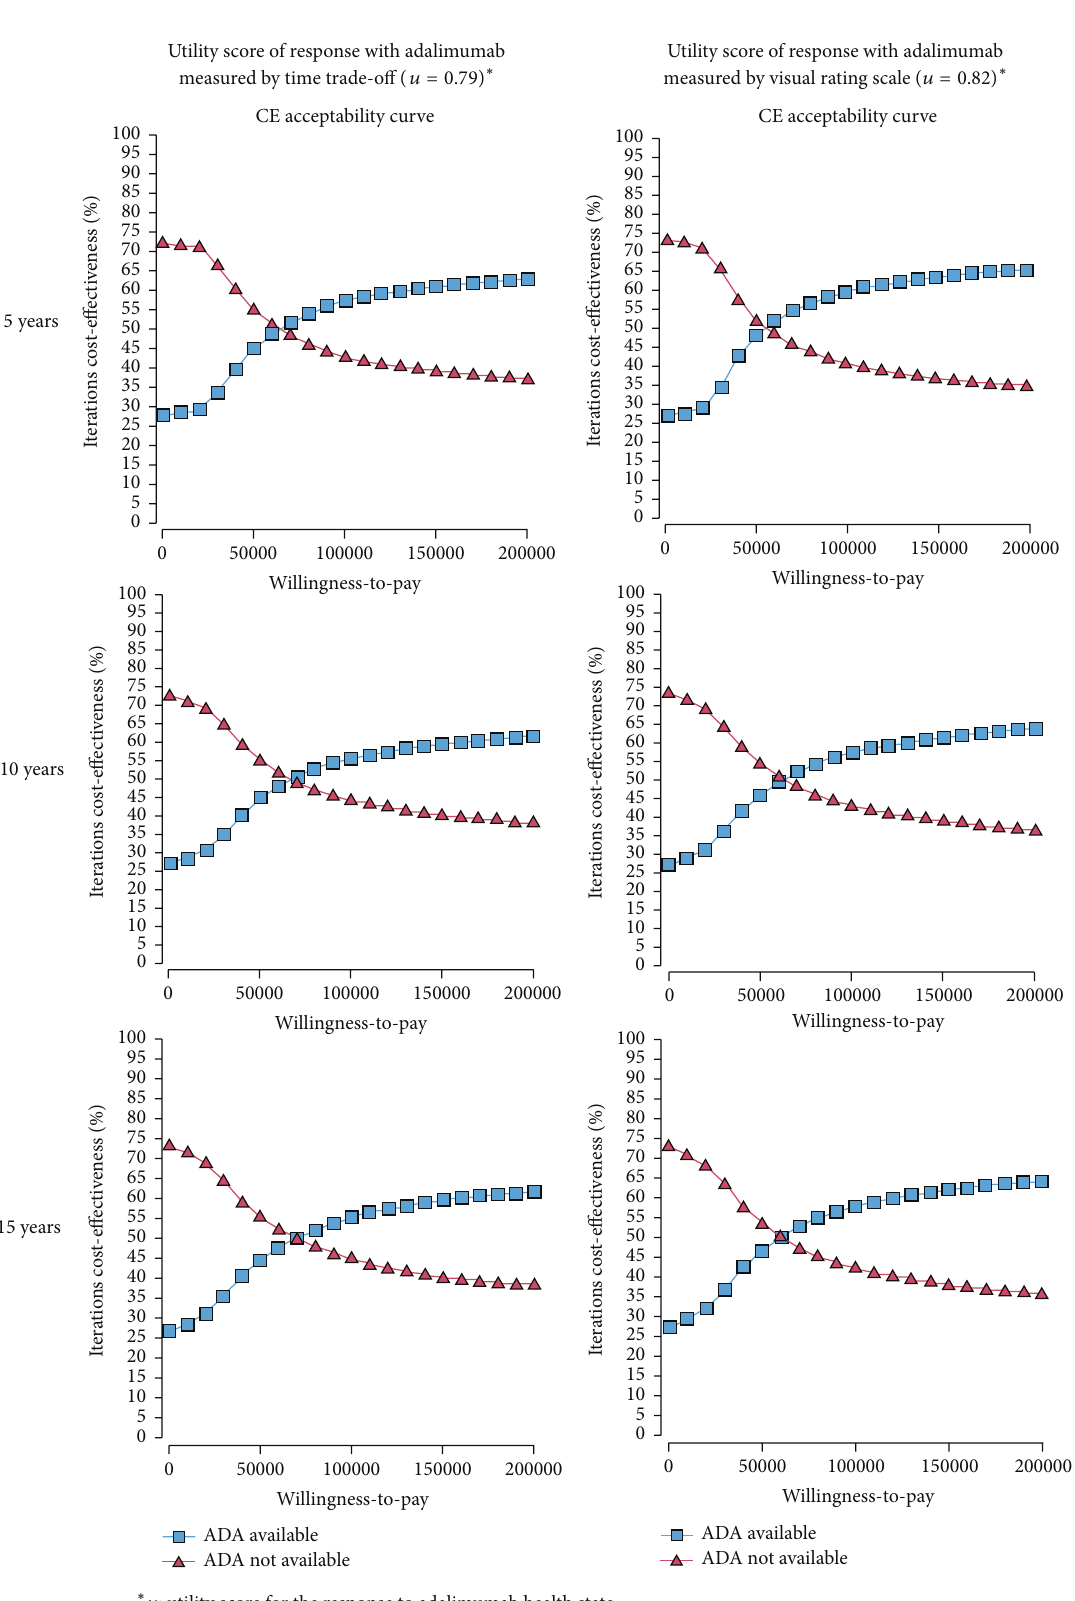
Figure 2: Cost-effectiveness acceptability